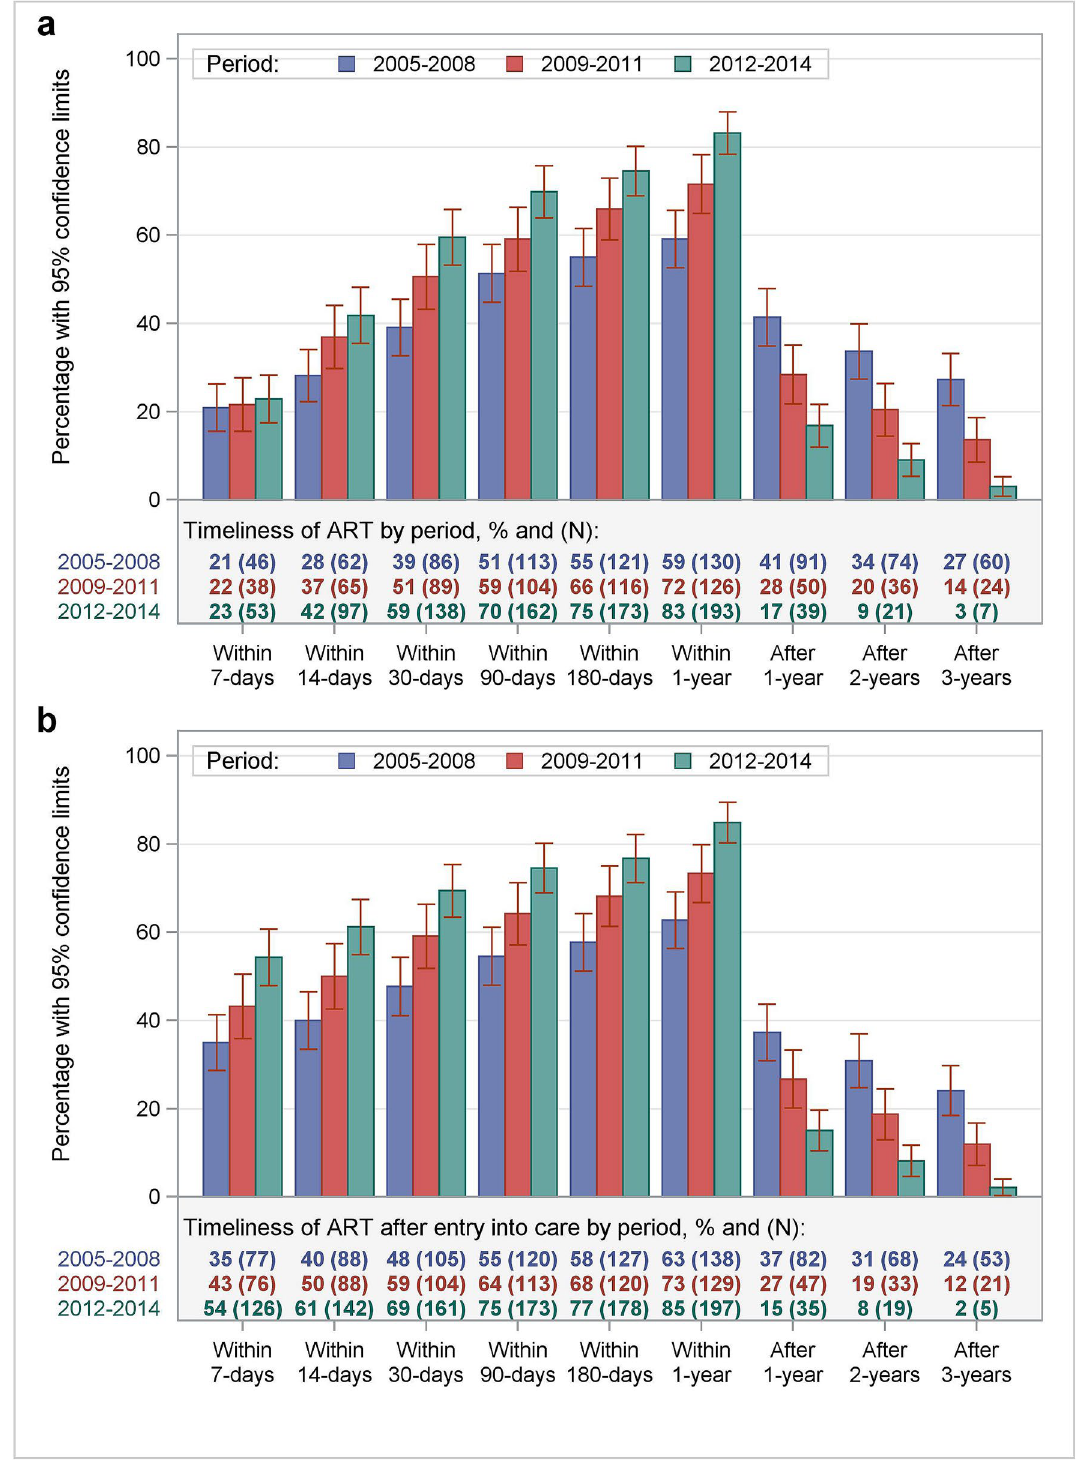
Figure 1. Time from HIV diagnosis to antiretroviral therapy (ART) initiation according to study periods. ( a ) Shows the frequency distribution of time from HIV diagnosis to ART initiation and ( b ) shows the frequency distribution of time from entry into care to ART